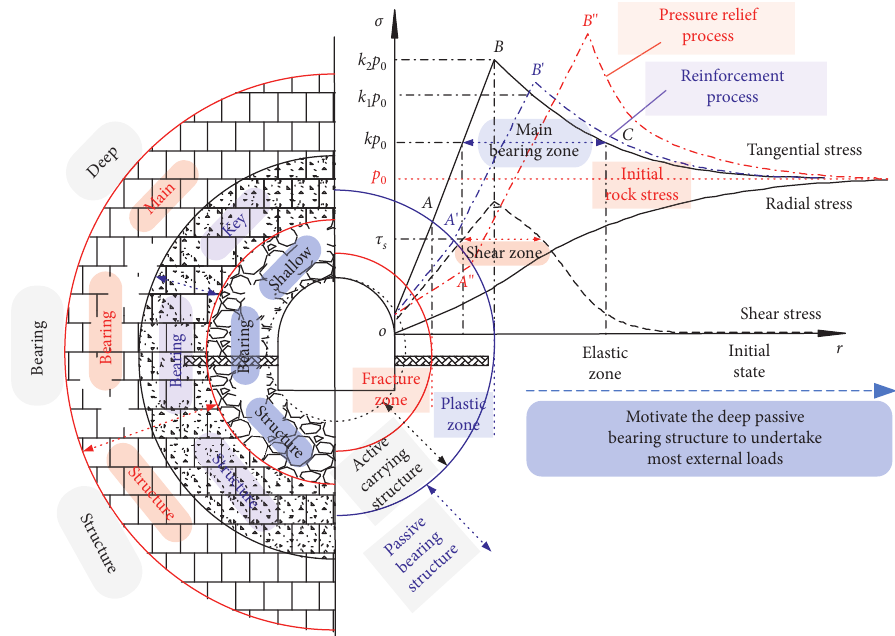
Figure 3: Relations between surrounding rock stress and bearing structure in a